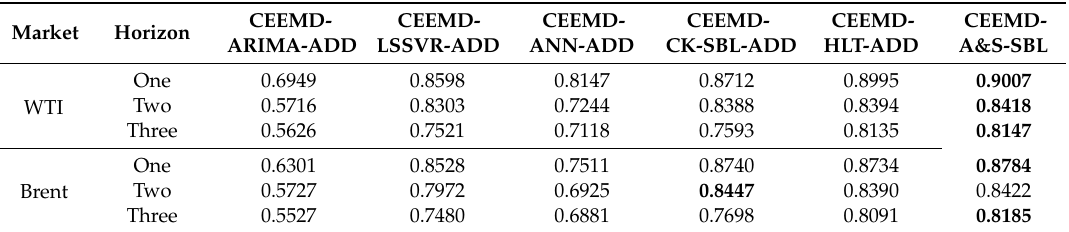
Table 5. The directional statistic (Dstat) values of different prediction models on WTI and Brent crude oil